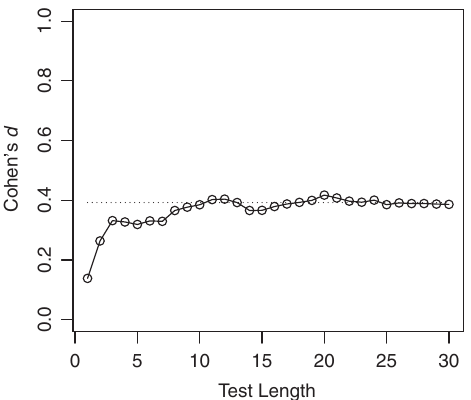
FIG. 3. The typical trend of Cohen ’ s d as a function of test length of the FCI-CAT, determined by Monte Carlo simulation (class size ¼ 80 ). The true value of Cohen ’ s d is 0.38 as shown by a dotted